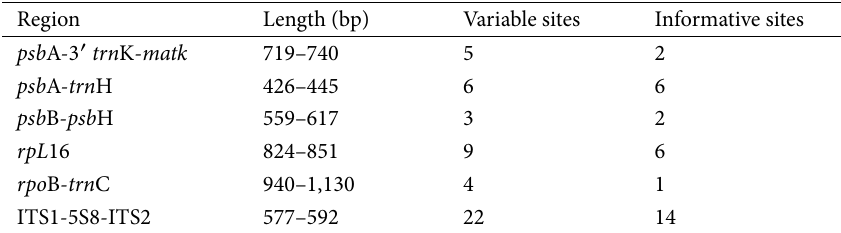
Table 2 Characteristics of the aligned Hedera